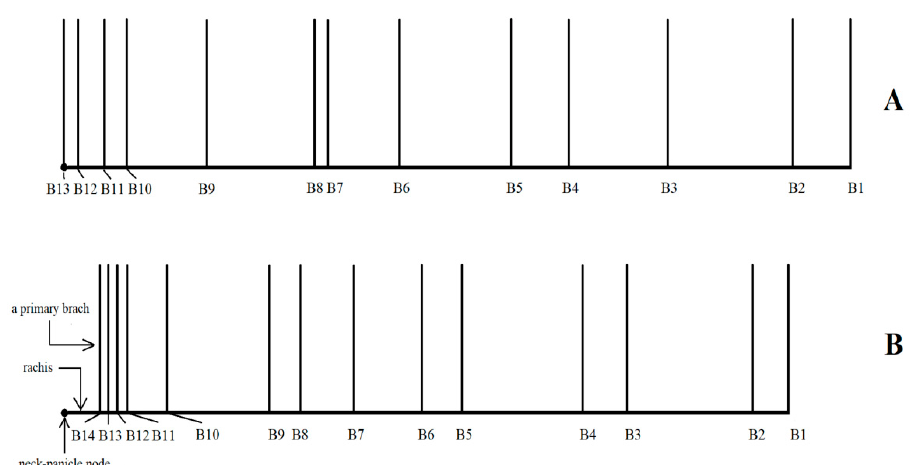
Figure 7. The distribution of all primary-branch grains at different positions for Nongle 1 ( A ) and Guifeng 2 ( B ) on the panicle axis. B1 to B14 represent the 1st primary-branch grains to the 14th primary-branch grains from the top to the base of the panicle for Nongle 1 and Guifeng 2.